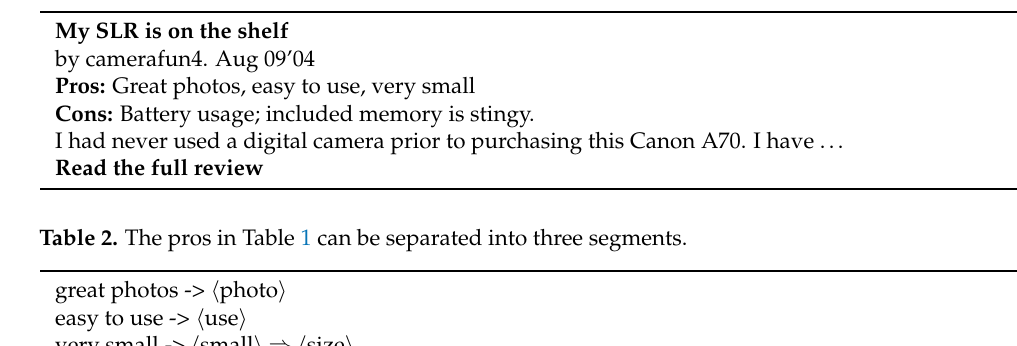
Table 1. An example review.